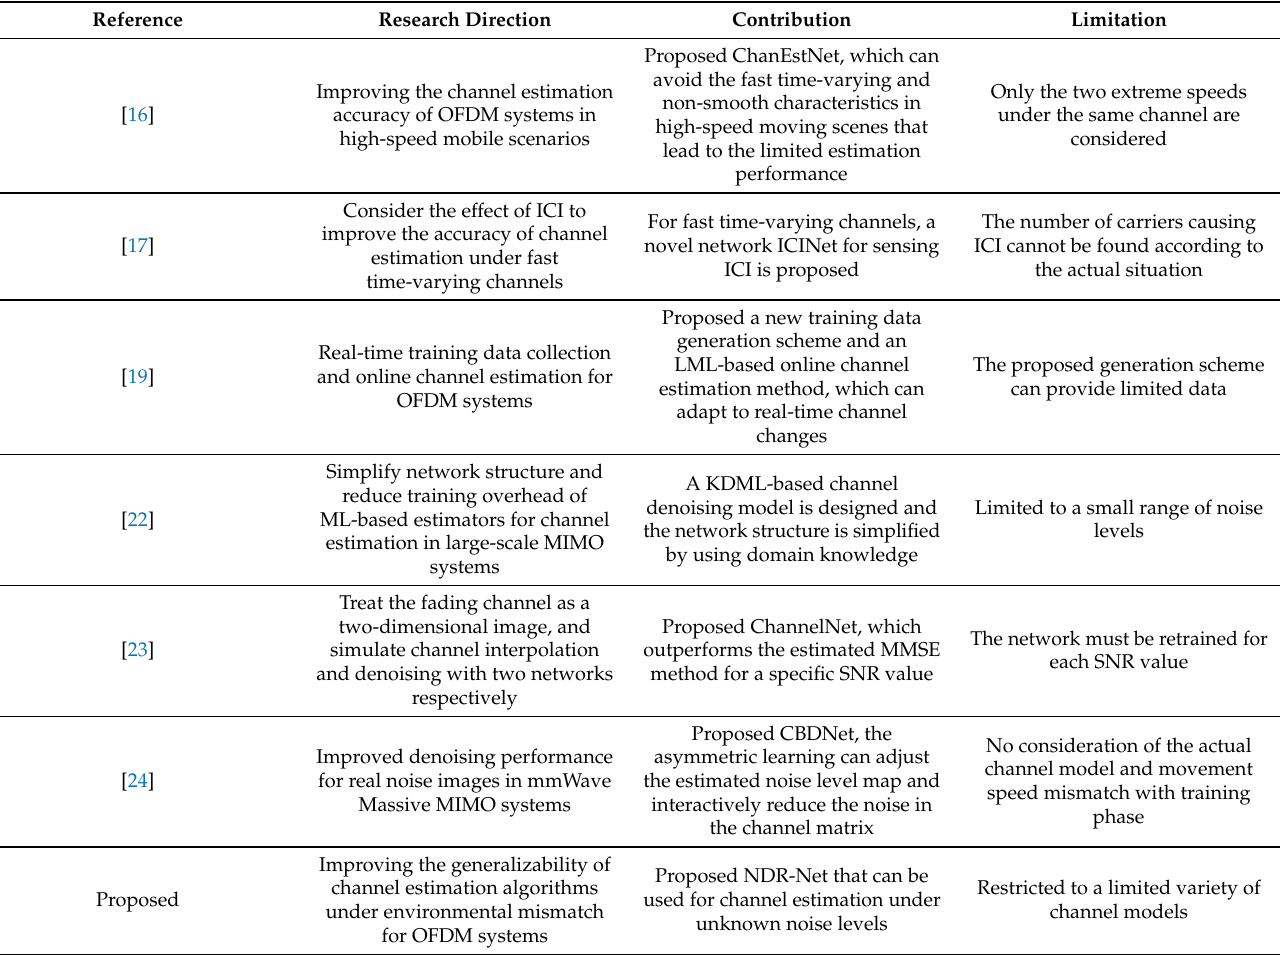
Table 1. List of related